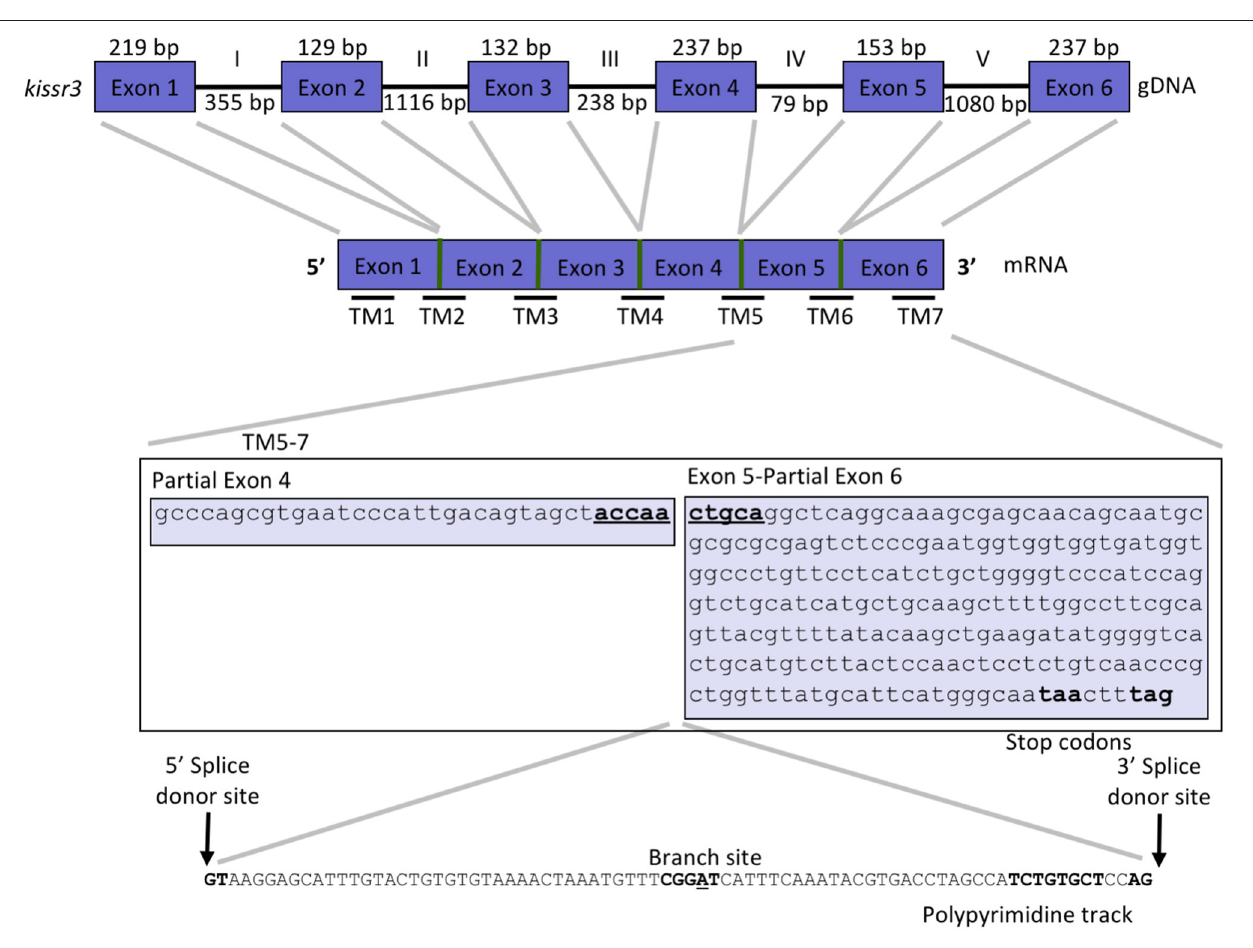
FIGURE 2 | Gene structure of kissr3 in pejerrey. Exons are displayed as blue boxes and introns as thick lines. Thinner horizontal lines at the bottom of the cDNA scheme, represent the site of the transmembrane domains (TMs). A detail of pejerrey intron 4 of kissr3 sequence with features consistent with the presence of a mechanism for alternative splicing is